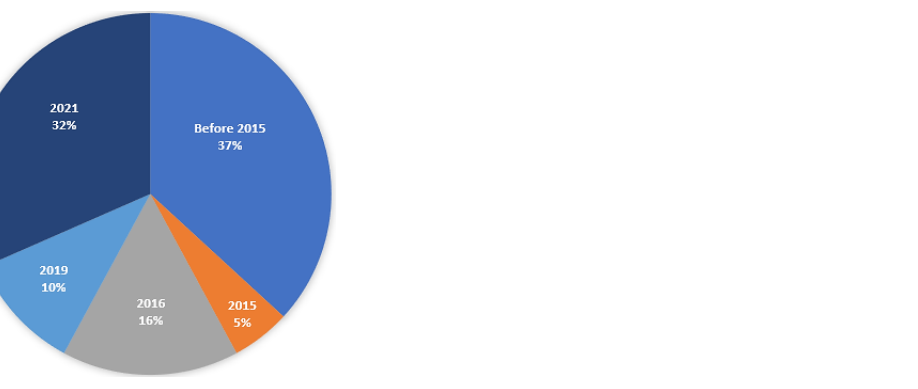
Figure 2. Number of publications per year according to Scopus search results .